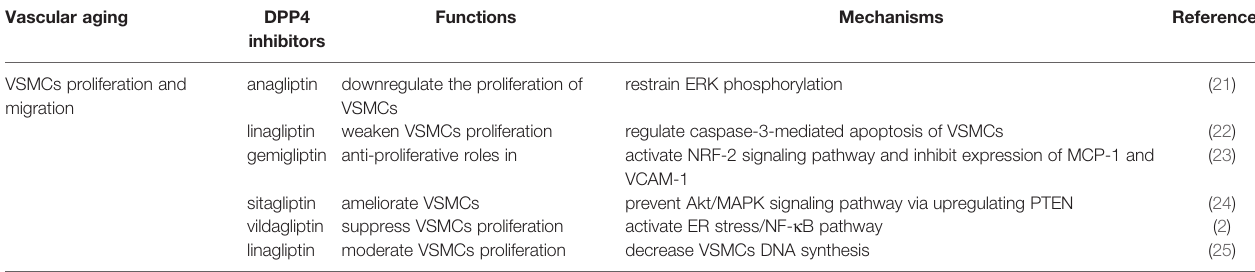
TABLE 2 | DPP4 inhibitors associated with vascular function and mechanisms in VSMCs